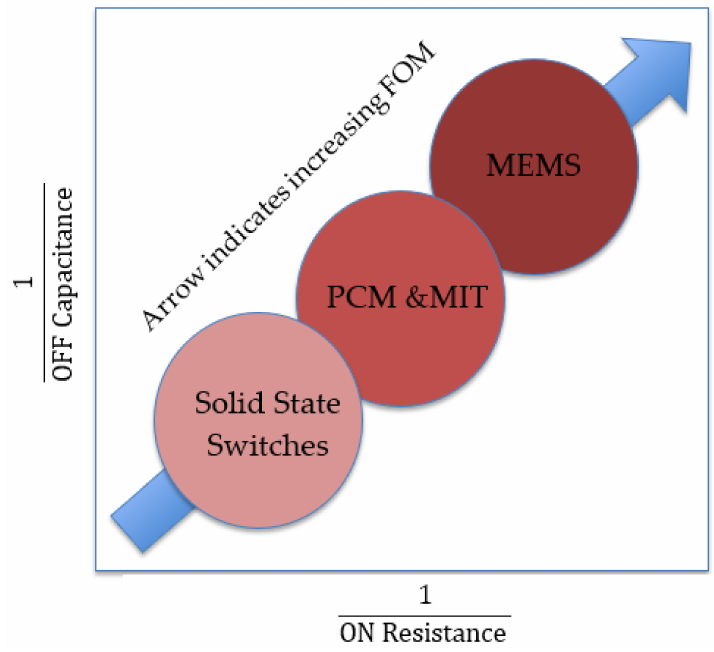
Figure 1. Comparison of figures of merit (FOM) of various radio frequency (RF) switching